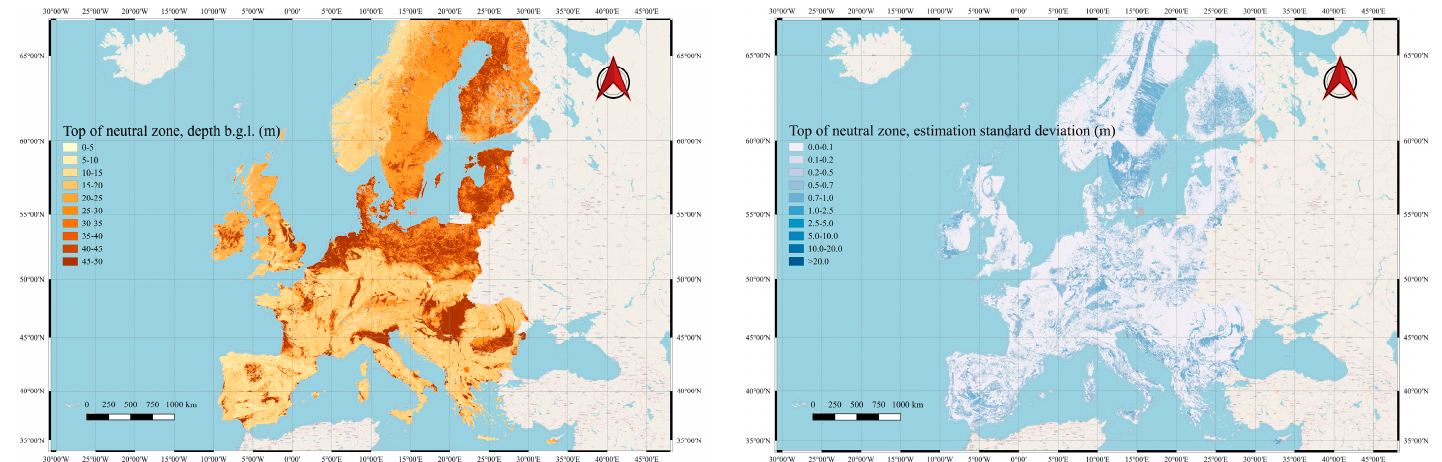
Figure 4. Estimation of average ( Left ) and standard deviation ( Right ) of top layer depth of neutral zone in Europe.